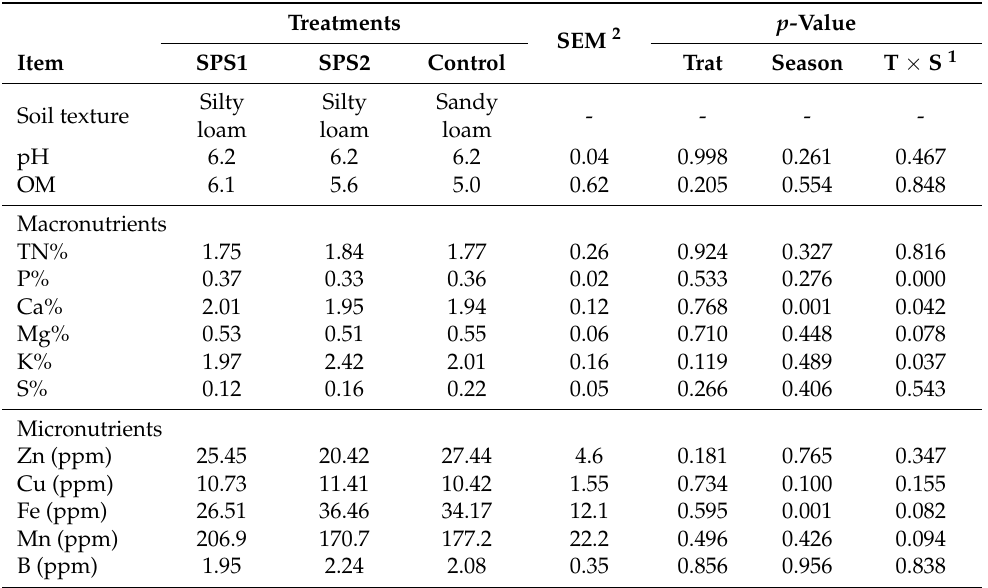
Table 5. Soil physical and chemical properties in different silvopastoral systems with Panicum maximum cv. Mombaça. p- Value Treatments SEM 2 Item SPS1 SPS2 Control